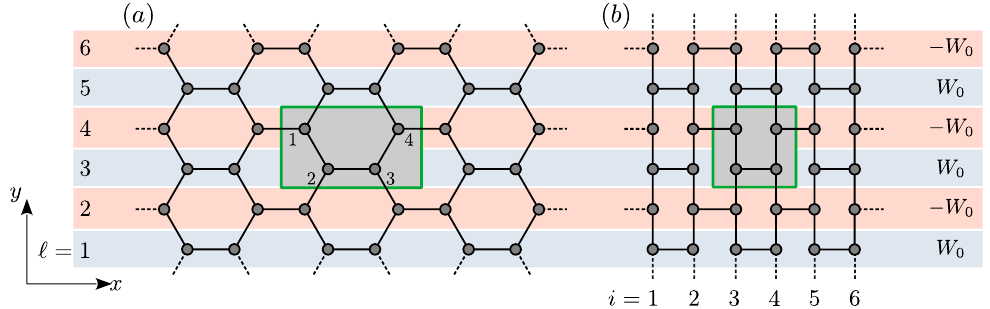
Figure 1: Schematic of the 2D periodic lattices considered in the main text: (a), the honeycomb lattice with alternating values of on-site potential along the y -direction; and, (b), the transformed version obtained by straightening the bonds along the y -axis. The y -layers are indexed by (cid:96) = 1,2,... and are highlighted by blue (red) backgrounds indicating the presence of an on-site potential W The dashed black lines represent the bonds connecting the lattice across the bound- aries. Each unit cell, delineated by a green rectangle, contains four sites labeled by the numbers 1 to 4. The stripes along the y -direction are indexed by i = 1,2,... in panel